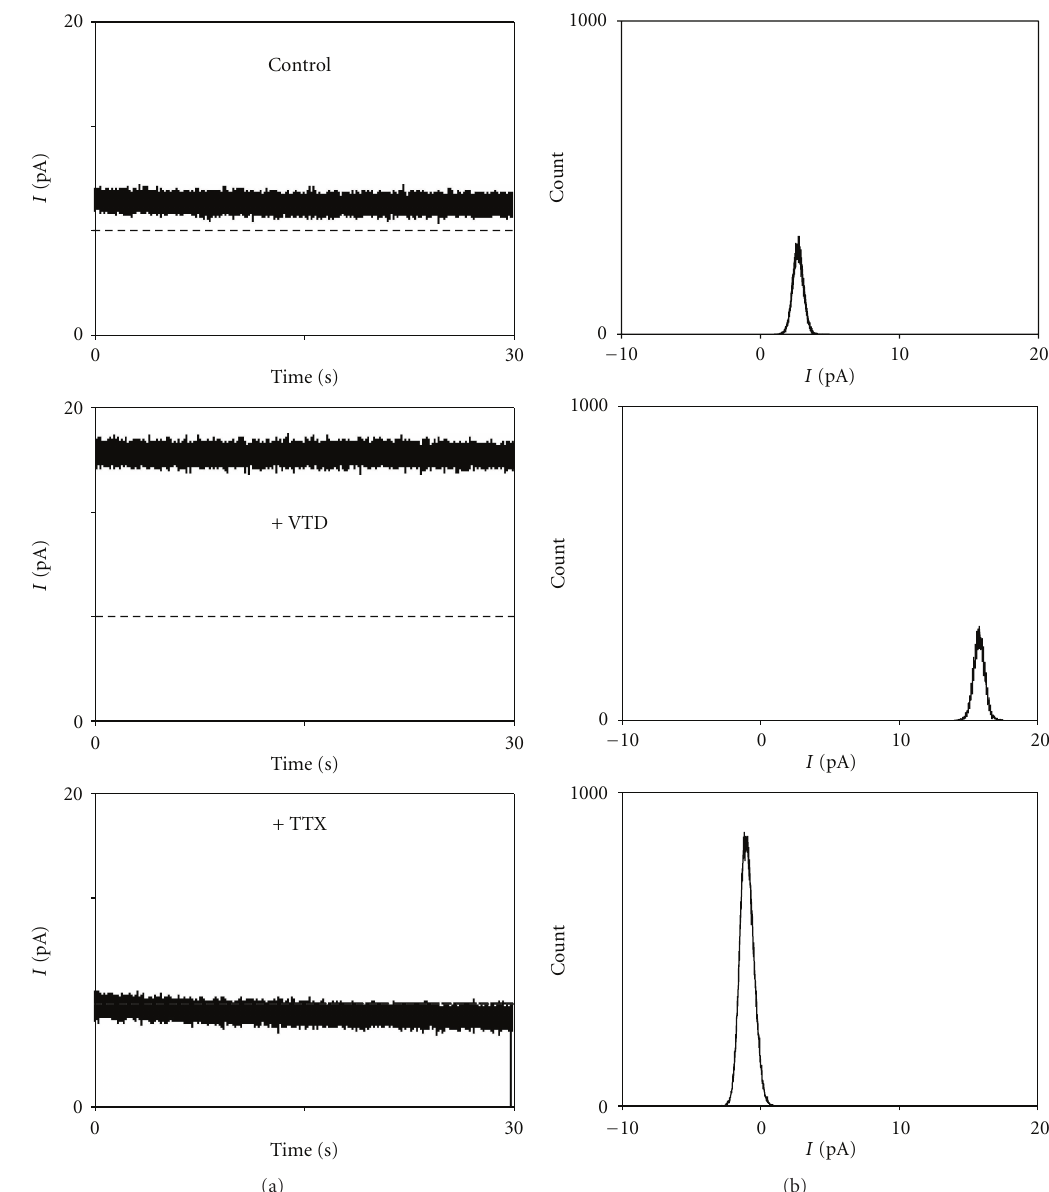
Figure 2: (a) Current recordings from a single experiment are shown for a PTFE filter preloaded with voltage-gated sodium channel (VGSC) liposomes. A BLM was formed on the PTFE filter and the control current level shown after 15min at +80mV. The current level is shown 15min after addition of 100 μ M veratridine (VTD) to both sides of the BLM, then 15min after addition of 100 nM tetrodotoxin (TTX). (b) Corresponding histograms show the current amplitude distribution over the period of the recording.